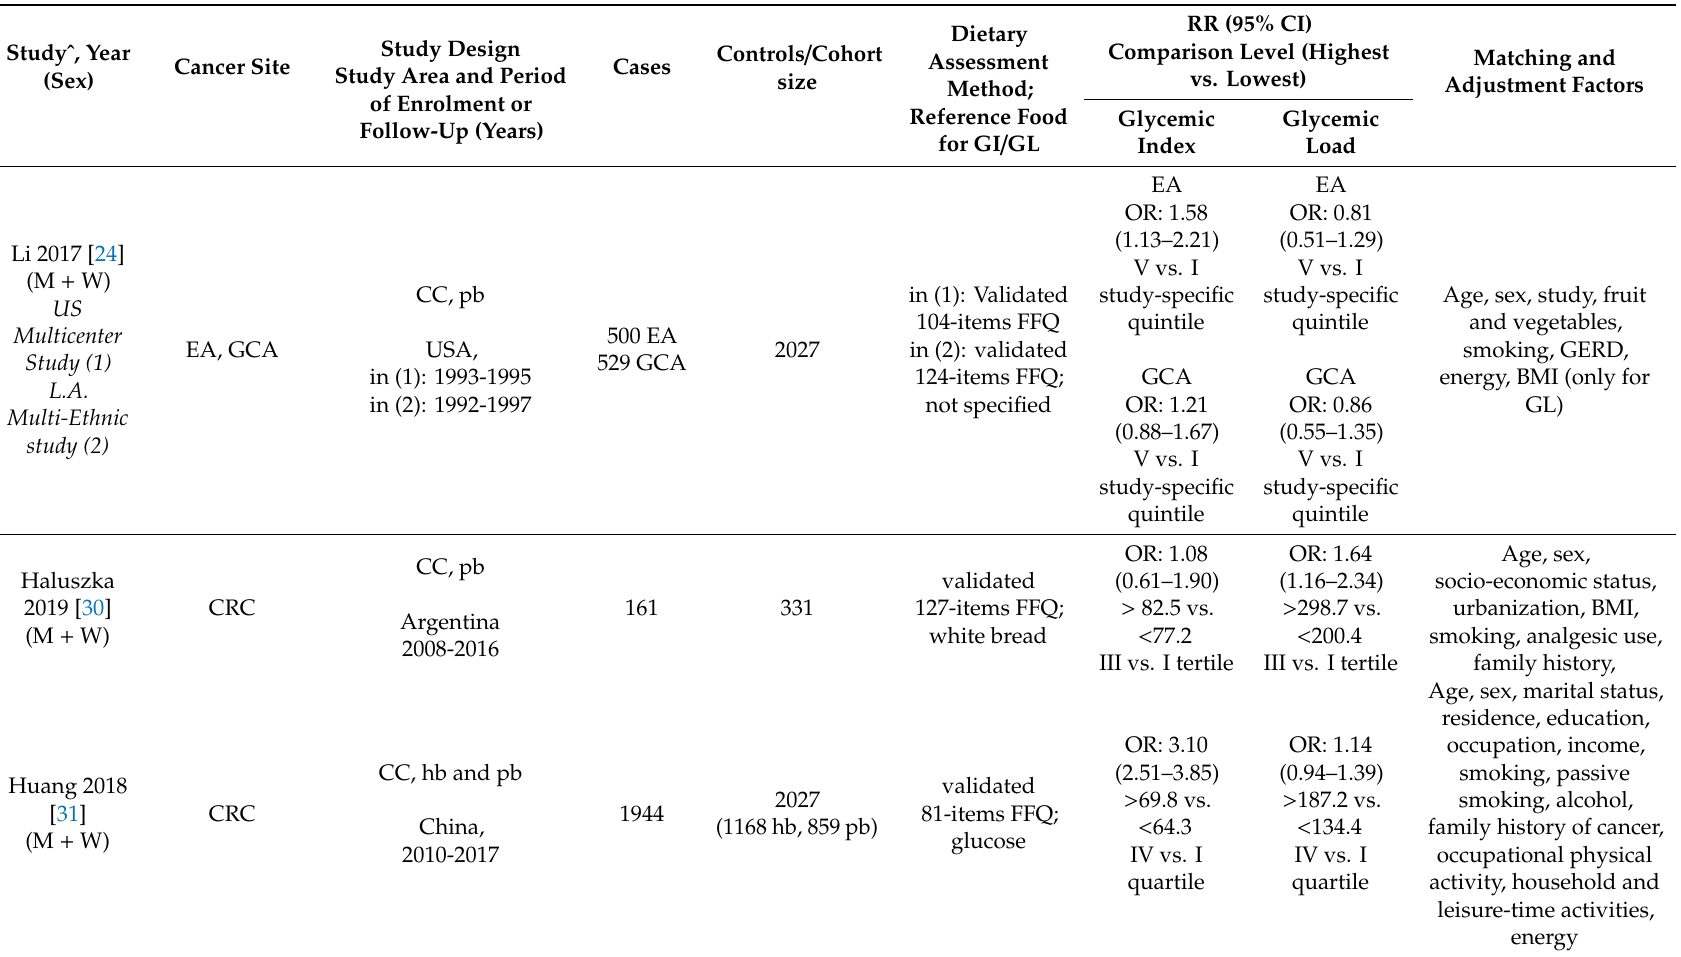
Table 1. Main characteristics of the studies included in the systematic